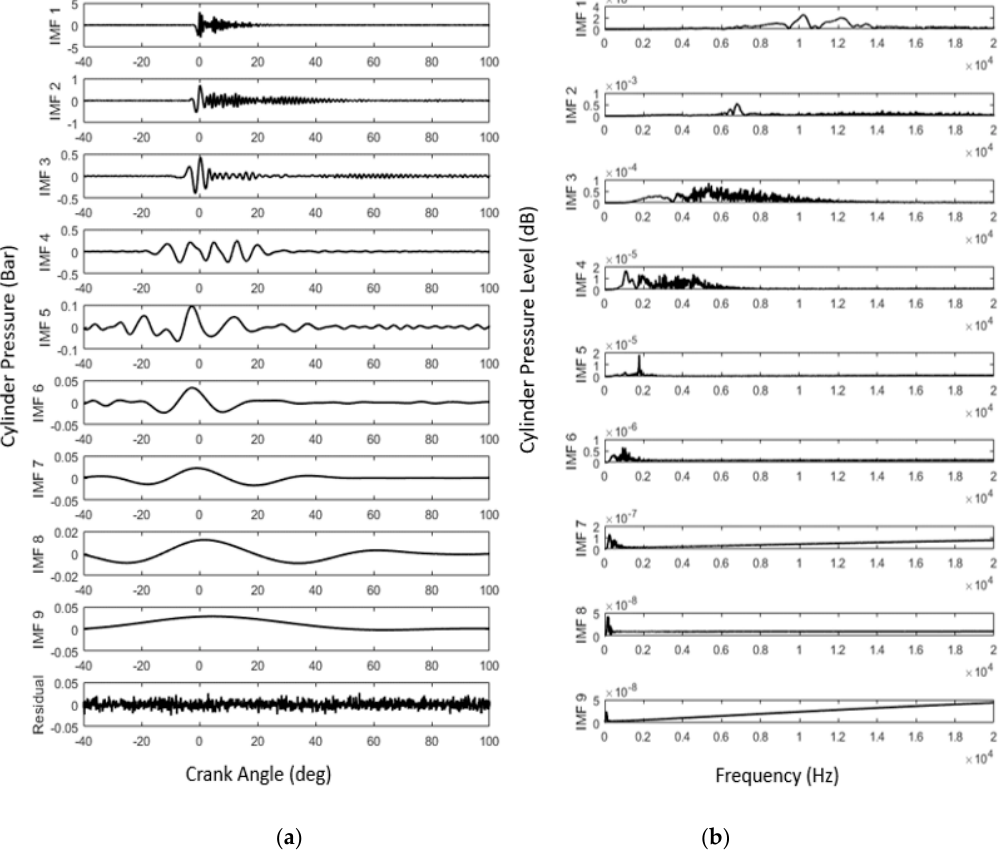
Figure 4. Decomposed results of the in-cylinder pressure under 1400 r / min full load condition by ensemble empirical mode decomposition (EEMD): ( a ) angle domain results; ( b ) frequency domain results.